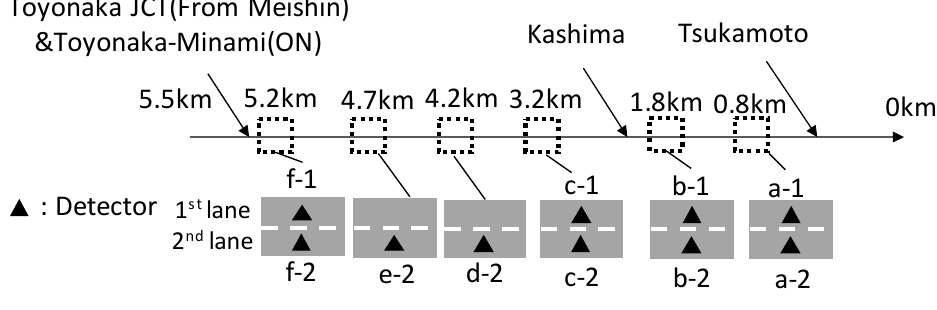
Figure 4. Simulation network.